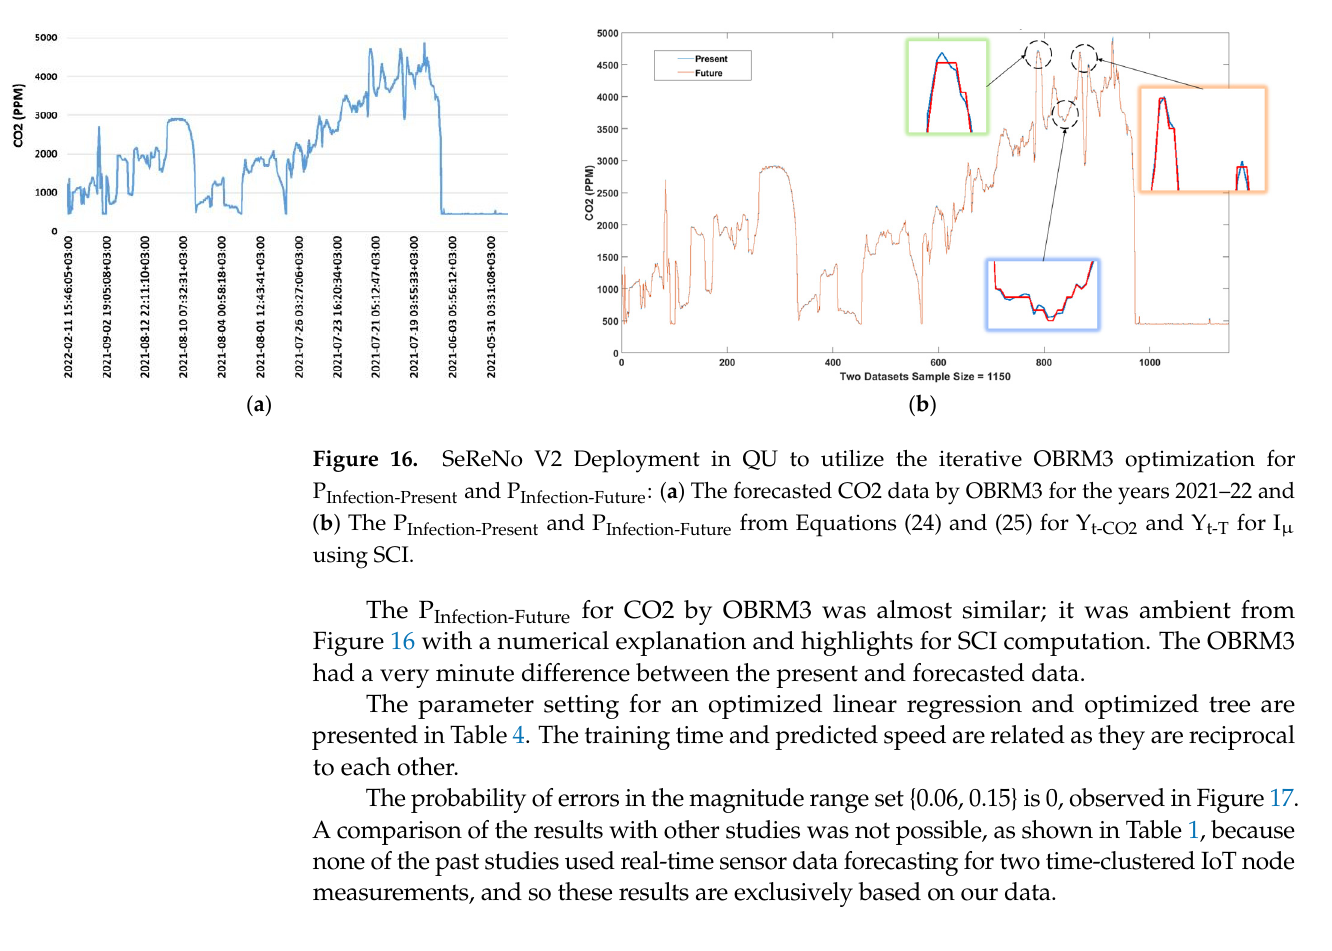
Figure 15. The Optimization of OBRM2 for CO2 to achieve OBRM3.